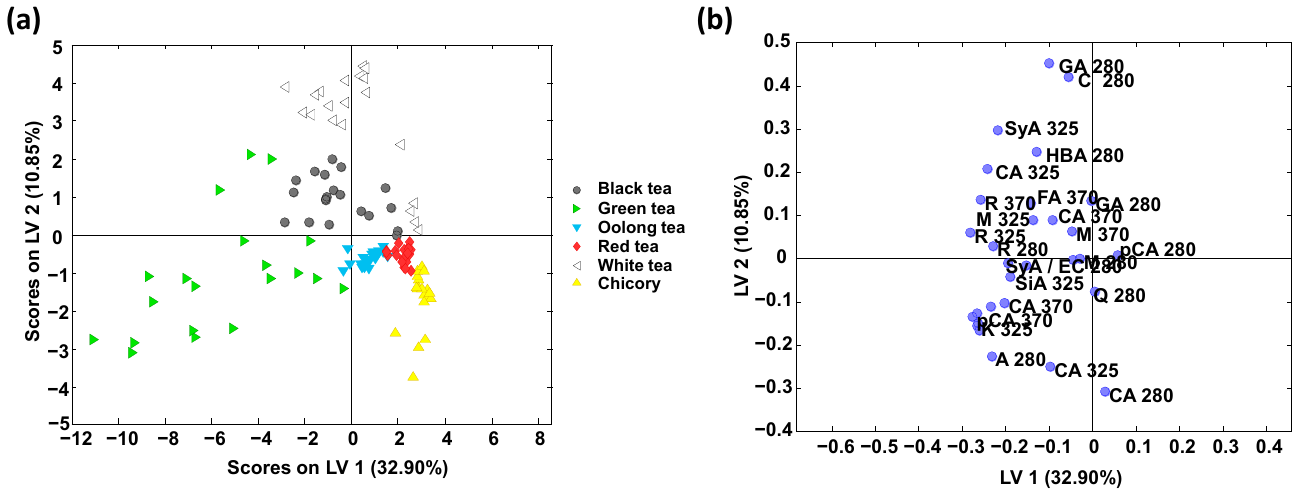
Figure 3. PLS-DA score plot ( a ) and loading plot ( b ) of LV1 versus LV2 when using targeted HPLC- UV polyphenolic profiles as sample chemical descriptors for the classification of tea and chicory samples. Six LVs were employed to build the model. Compound identification: gallic acid, GA; protocatechuic acid, PA; quercetin, Q; ( − )-epigallocatechin, EGC; (+)-catechin, C; 4-hydroxybenzoic acid, HBA; vanillic acid, VA; caffeic acid, CA; syringic acid, SyA; ( − )-epicatechin, EC; p -coumaric acid, pCA; ferulic acid, FA; sinapic acid, SiA; rutin, R; myrcetin, M; apigenin, A; kaempferol, K. A paired PLS-DA model was built to classify the tea varieties analyzed versus chicory. With this in mind, 60% of the samples randomly selected were used for calibration, while the remaining 40% (considered “unknown samples”) were used for validation and prediction. Figure S2 (Supplementary Materials) depicts the obtained validation results.